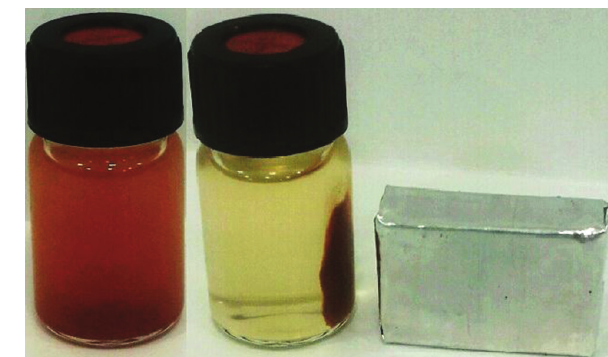
Figure 7: Isolation of MMNP by employing an external